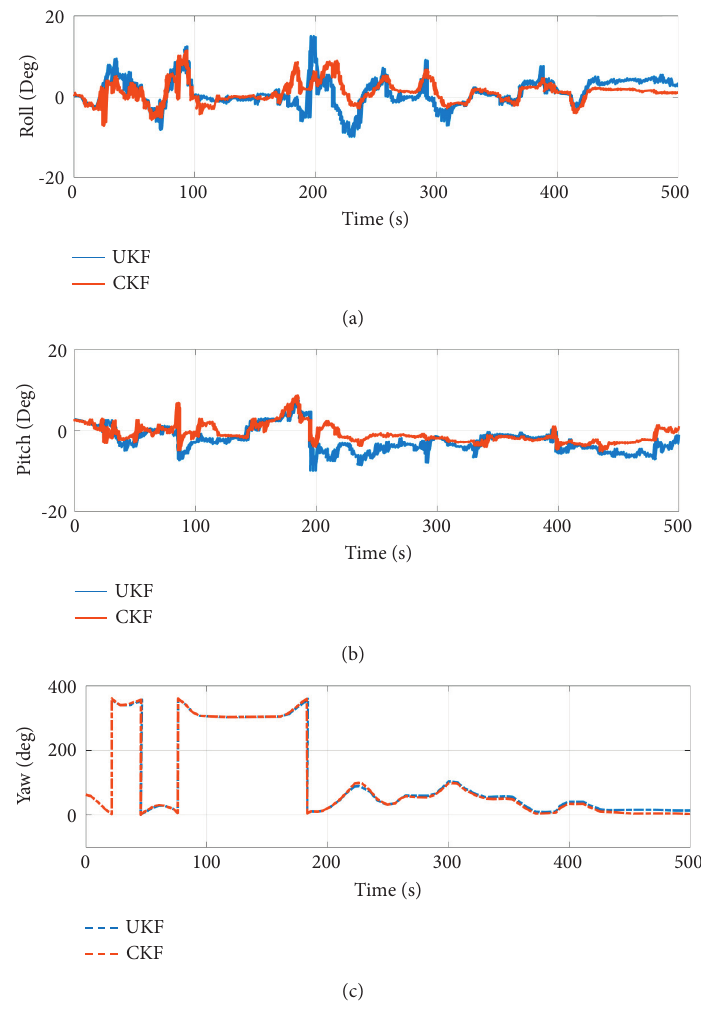
Figure 2: Estimation of EA. Table 1: Position and orientation